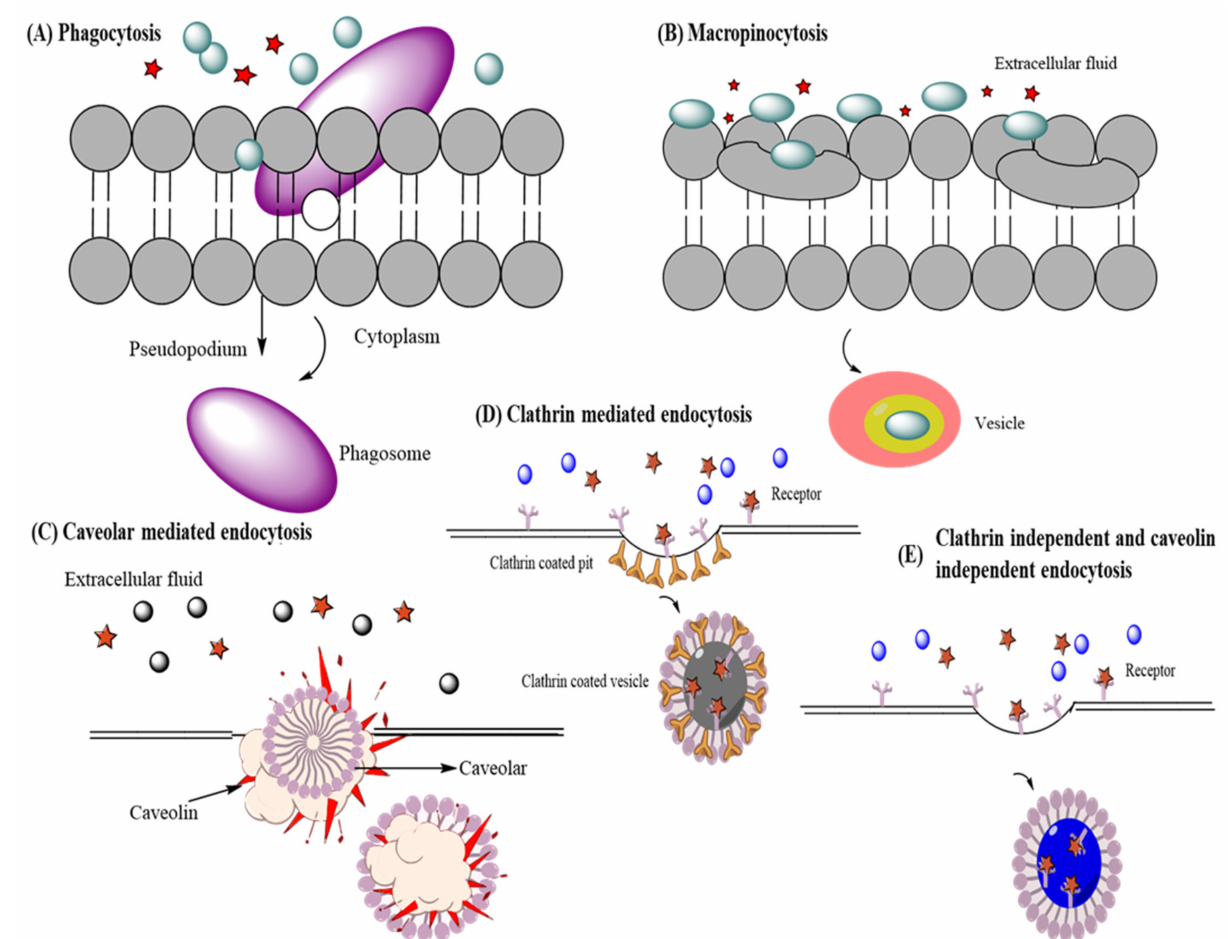
Figure 6. Mechanism and different pathways of internalization of DNA conjugate nanoparticles. ( A ) Phagocytosis; ( B ) Macropinocytosis; ( C ) Caveolar mediated endocytosis; ( D ) Clathrin mediated endocytosis; and ( E ) Clathrin independent and caveolin independent